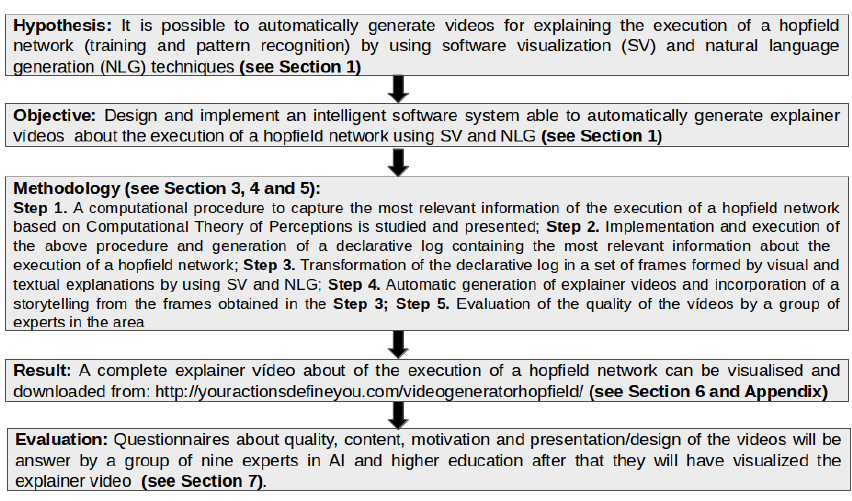
Figure 1. A general framework for transforming the execution of an algorithm in an explainer video using data-to-text and software visualization techniques.